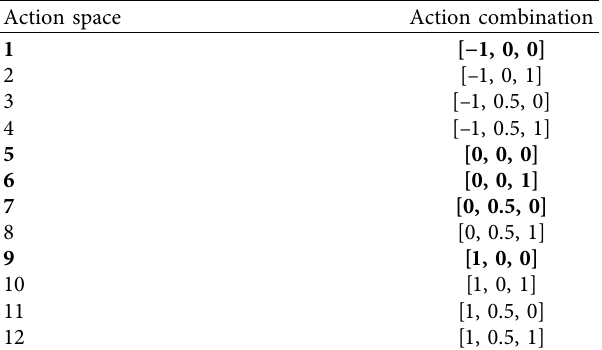
Table 4: Action space.